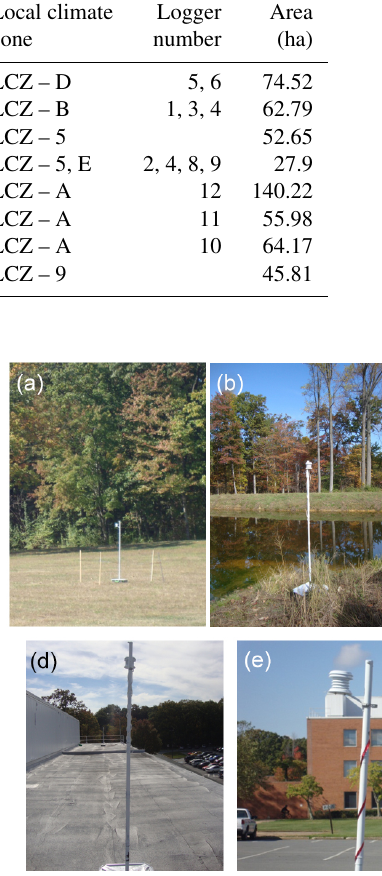
Figure 3. Photo montage of loggers installed at NASA